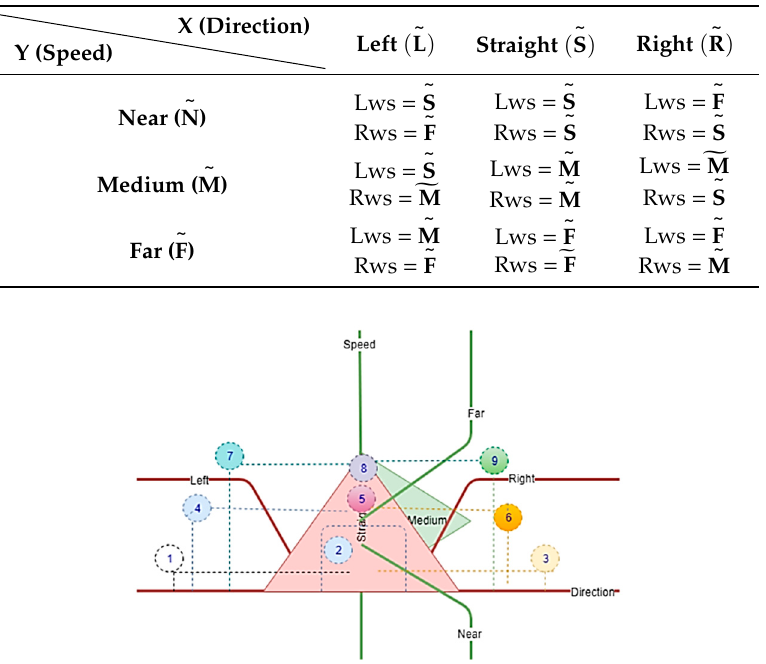
Table 2. Rule base for robot wheel speed fuzzy controller.